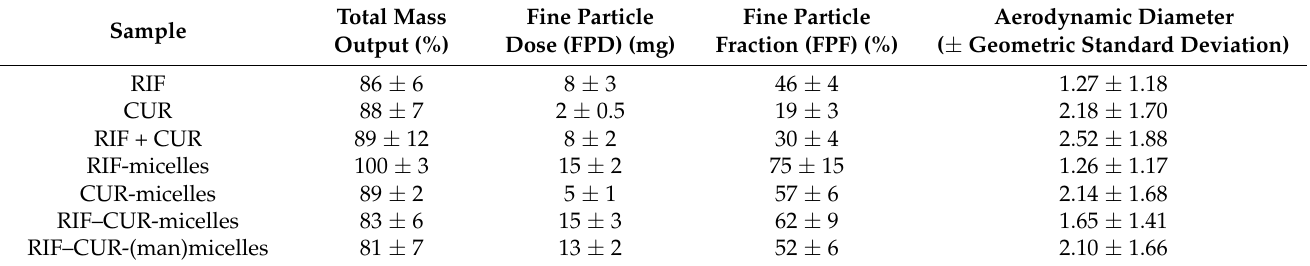
Table 4. Total mass output (TMO%), fine particle dose (FPD, mg), fine particle fraction (FPF, %) and mass median aerodynamic diameter (MMAD) of nanosystems nebulized by using the next generation impactor (NGI). FPD and FPF values are shown as mean ± S.D. of three experiments; MMAD values are shown as mean ± geometric standard